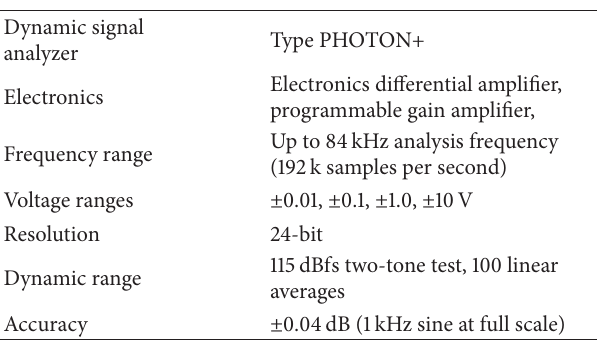
Table 13: Specifications of FFT